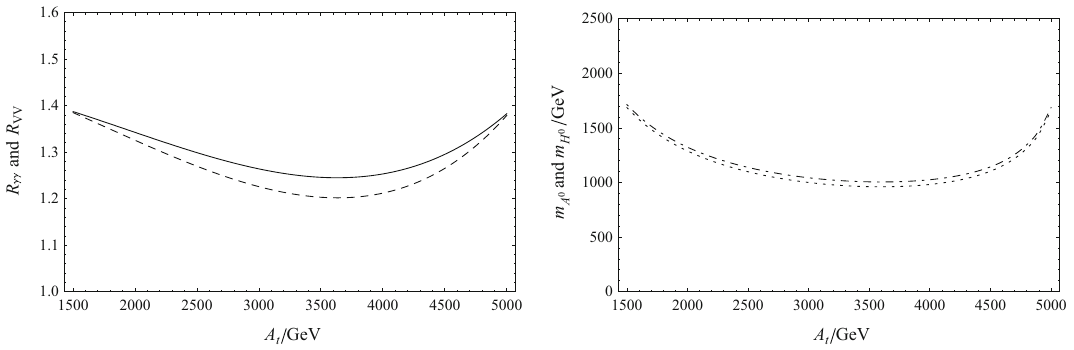
Fig. 2 The results versus A t are shown. R γγ (solid line) and R VV (dashed line) are in the left diagram. m A 0 (dot-dashed line) and m H 0 (dotted line) are in the right diagram